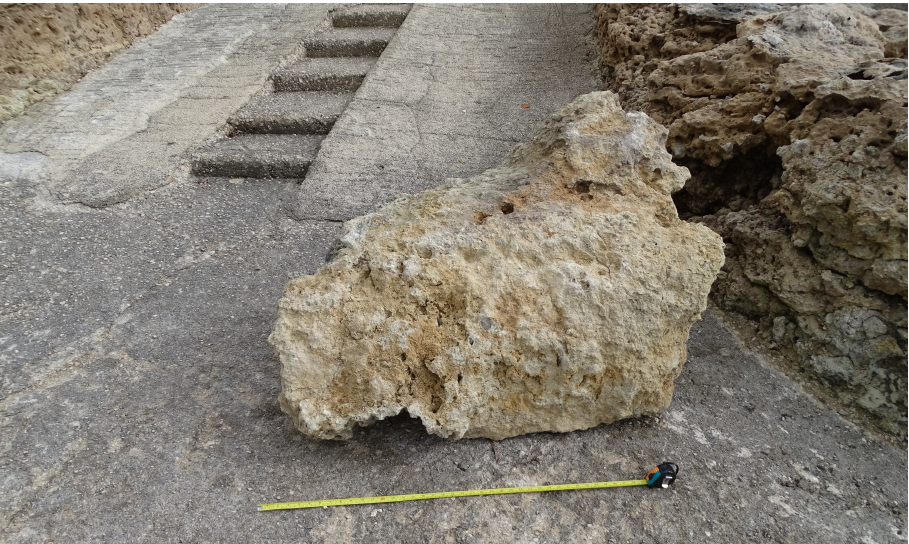
Figure A5. The boulder SUi, onshore displaced by the October 2018 storm. It was later re-mobilized as confirmed by the June 2020 GE image, where the boulder is placed further